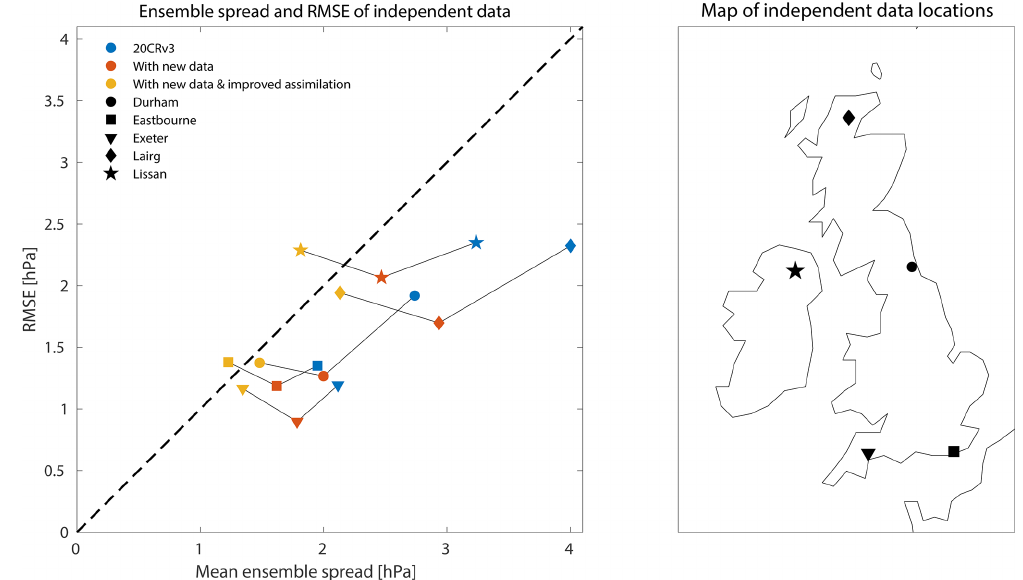
Figure B1. Ensemble reliability. Mean ensemble spread of the reanalysis and RMSE of the reanalysis compared to unassimilated independent observations for five locations (shapes) during February 1903. Different versions of the reanalysis are shown with different colours. None of these observations are assimilated in any version of the reanalysis. Adding the additional observations reduces both the ensemble spread and the RMSE (moving from blue to red symbols), and the improved assimilation has made the reanalysis more reliable (moving from red to yellow symbols, RTPS reduced from 0.9 to 0.5), with a small increase in RMSE. The dashed line represents “perfect” ensemble reliability, when RMSE and ensemble spread are equal.